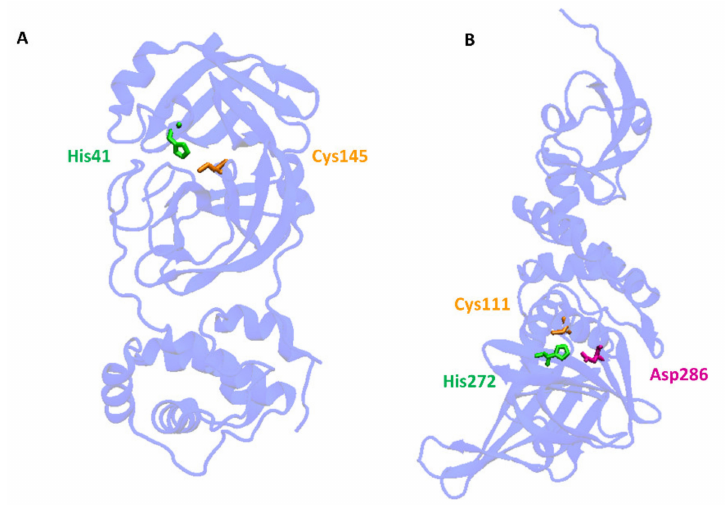
Figure 3. Structures of two pivotal SARS-CoV-2 proteases: ( A ) main protease (Mpro) called also 3-chymotrypsin-like protease (3CLpro) (PDB: 6LU7) and ( B ) papain-like protease (PLpro) (PDB: 6WUU). Catalytic center is formed by Cys145 and His41 in Mpro and by Cys111, His272, and Asp286 in